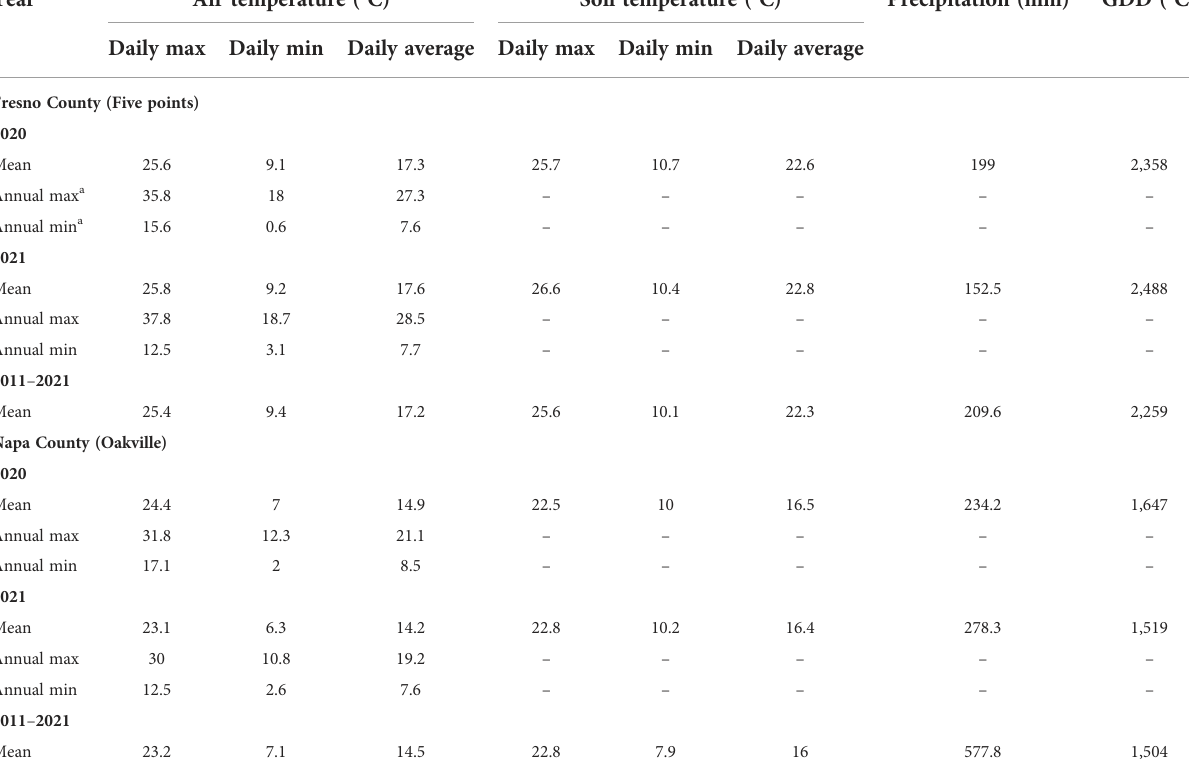
TABLE 1 Site conditions at two commercial vineyards in Fresno County and Napa County from experimental years (2019 – 2021) and long-term mean values (2011 –